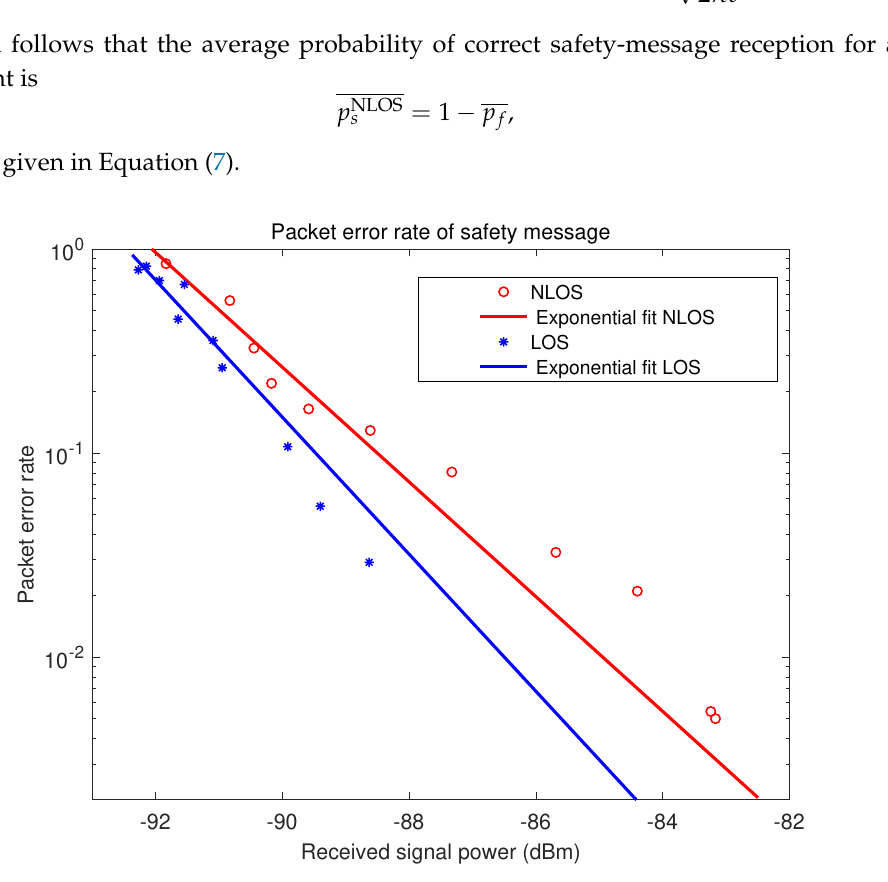
Figure 2. Packet error rate of safety messages using a commercial dedicated short-range communication (DSRC)